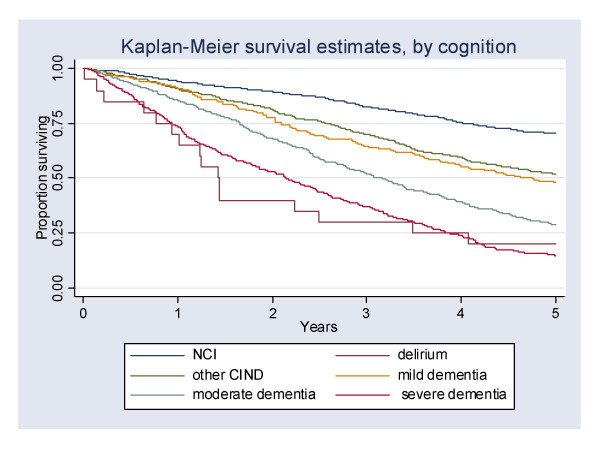
Kaplan-Meier survival curve illustrating five-year survival in delirium and cognitive impairment of graded severity. NCI = No cognitive impairment, CIND = Cognitive impairment, no dementia. Dementia severity was graded using the Global Deterioration Scale (GDS) as mild (GDS = 4) moderate (GDS = 5) or severe (GDS = 6) [12].